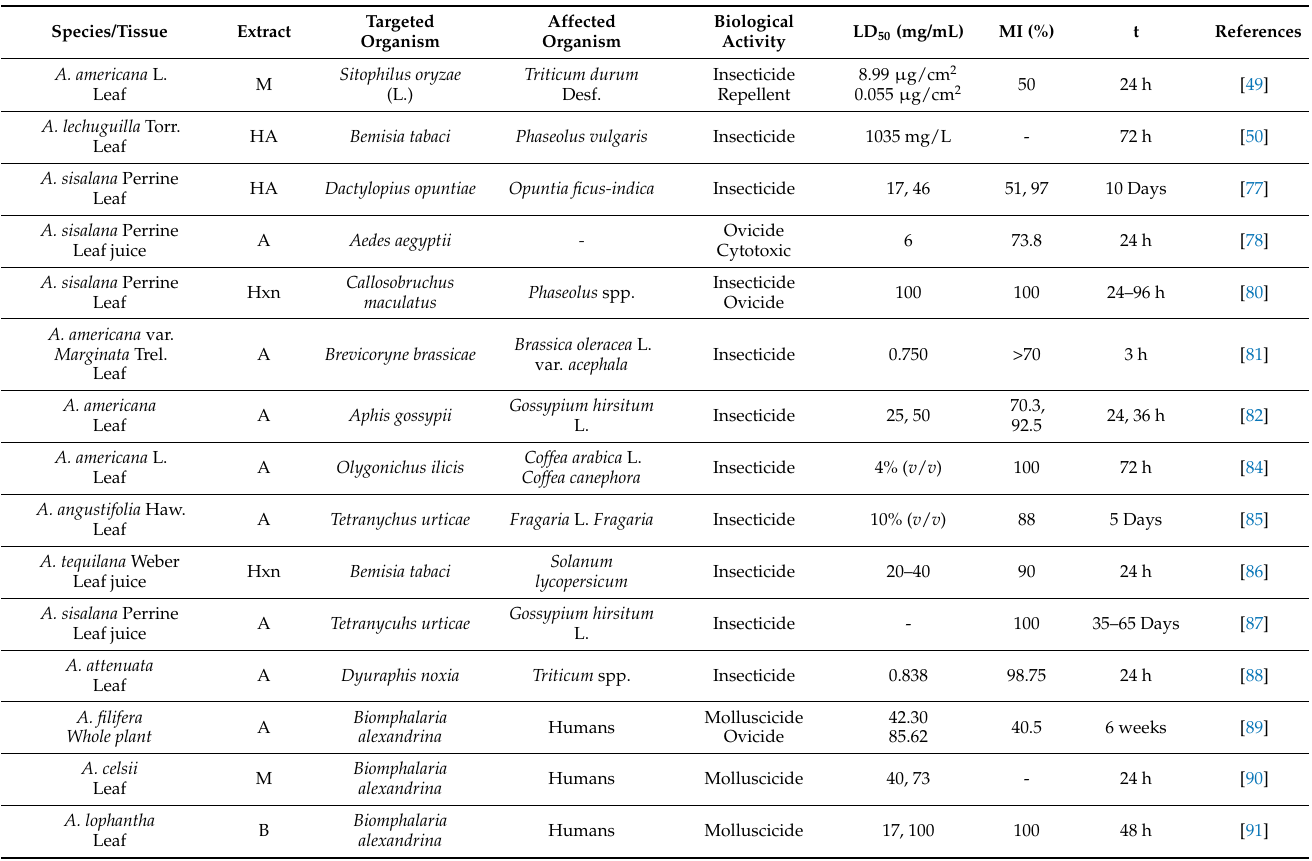
Table 3. Biopesticide potential of agave